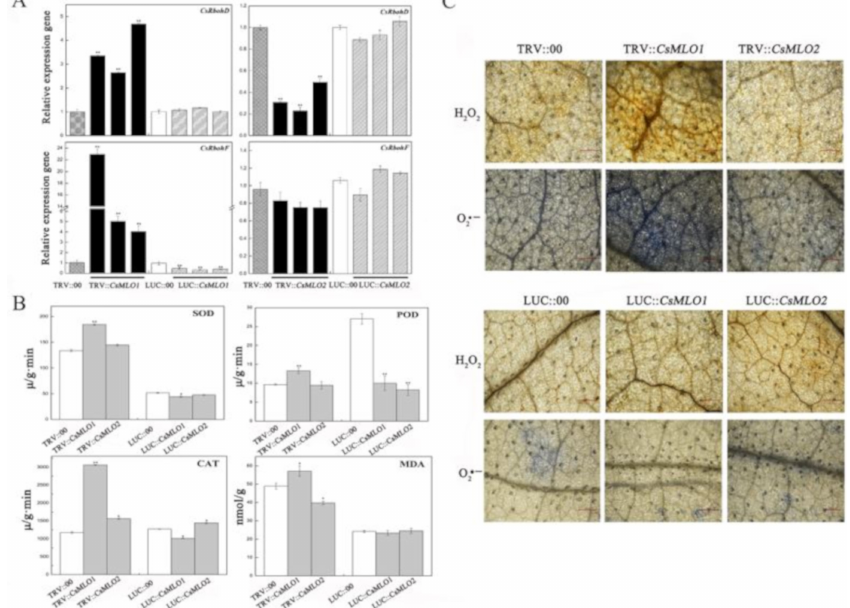
Figure 9. CsMLO1 and CsMLO2 transgenic plants modulate the ROS signaling. ( A ) The transcript level of CsRbohD and CsRbohF were detected by RT-qPCR in CsMLO1 / CsMLO2 -overexpressing and CsMLO1 / CsMLO2- silencing cucumber cotyledons. Data are means ± standard deviations from three independent experiments, and each column represents a sample containing six of cucumber cotyledons. Expression analysis of candidate genes using the 2 − ∆∆ Ct method. The asterisks indicated a significant di ff erence (Student’s t -test, *P < 0.05 or ** P < 0.01). ( B ) Antioxidant enzymes were examined in CsMLO1 and CsMLO2 transgenic plants. Data are means ± standard deviations three biological replicates per cultivar. The asterisks indicated a significant di ff erence (Student’s t -test, *P < 0.05 or ** P < 0.01); ( C ) ROS-related (H 2 O 2 and O 2 · − ) staining were shown in CsMLO1 / CsMLO2 -overexpressing and CsMLO1 / CsMLO2- silencing cucumber cotyledons. Data are means three biological replicates of per variety. Images of staining were obtained using a Nikon optical microscope. Scale bars = 500 µ